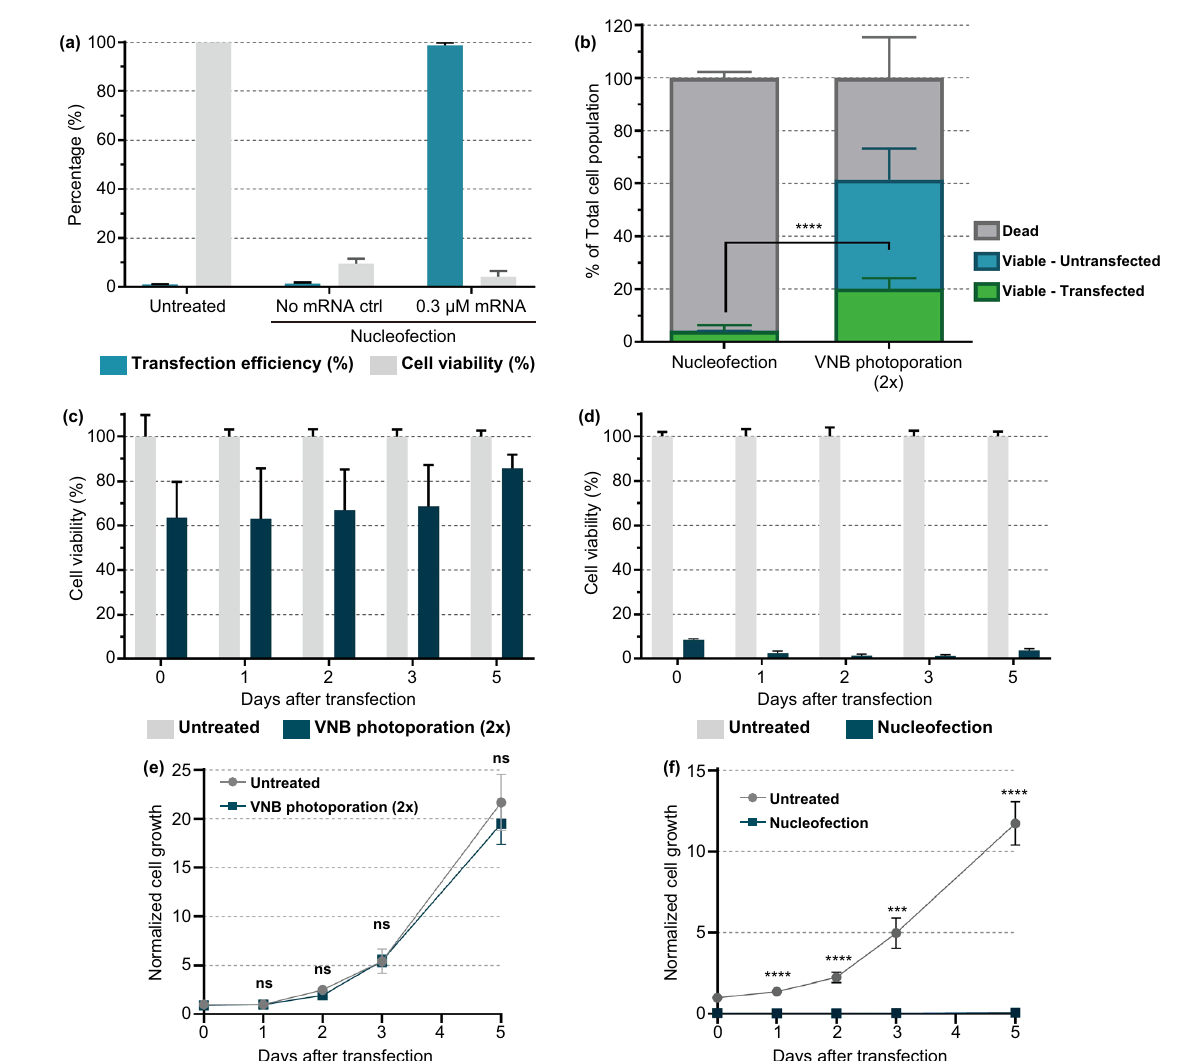
Fig. 7 Comparison of nucleofection and VNB photoporation for mRNA transfection in Jurkat cells. a Jurkat cells were transfected with eGFP- mRNA (0.3 µM) by nucleofection according to the manufacturer instructions. The transfection efficiency (i.e., % eGFP-positive cells) and cell viability by a CellTiter-Glo assay were determined 24 h post-transfection ( n = 3). b Comparison of nucleofection and VNB photoporation in terms of viable, transfected cell yield ( n ≥ 3, unpaired Student’s T test; **** p < .0001). c, d Cell viability after VNB photoporation ( c ) or nucleo- fection ( d ) was measured at different time points for 5 days post-transfection. On day 0, cell viability was determined 2 h post-transfection. Cell viability values were calculated relatively to the untreated control on each day ( n = 2 × 3 ) . e, f Normalized cell growth after VNB photoporation ( e ) or nucleofection ( f ) was measured at different time points for 5 days post-transfection. The normalized cell growth values were calculated relatively to the untreated control at day 0. Data are represented as the mean ± SEM ( n = 2 × 3, unpaired Student’s T tests; ns = nonsignificant, *** p < .001, **** p <